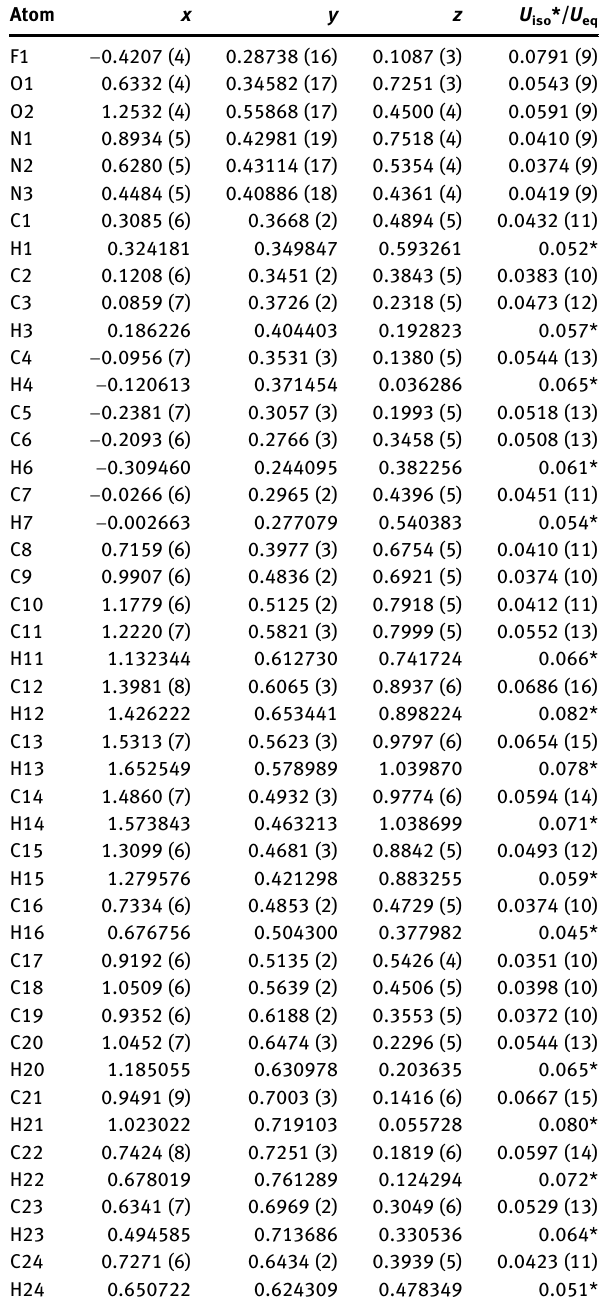
Table  : Fractional atomic coordinates and isotropic or equivalent isotropic displacement parameters (Å 